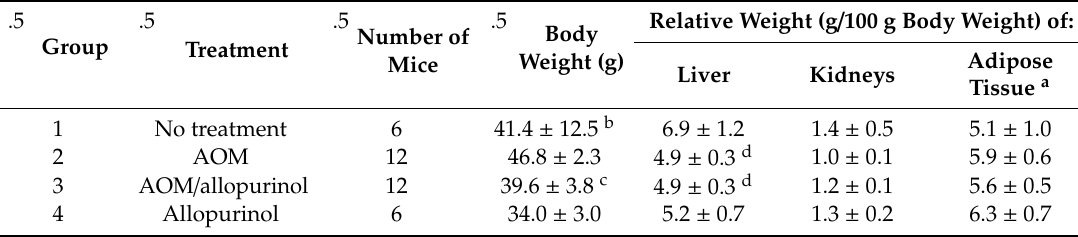
Table 1. General observations of the experimental mice.